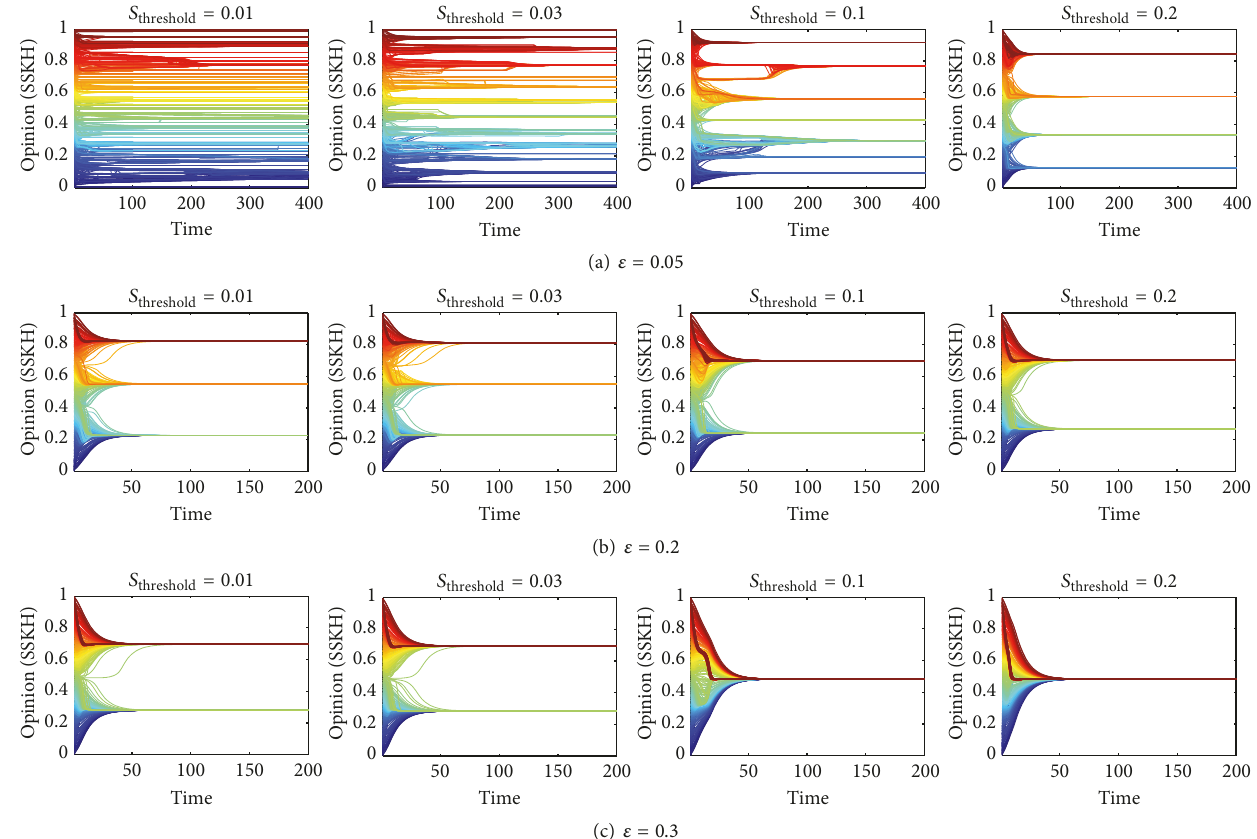
Figure 3: Influence of the similarity threshold on opinion evolution results under different confidence